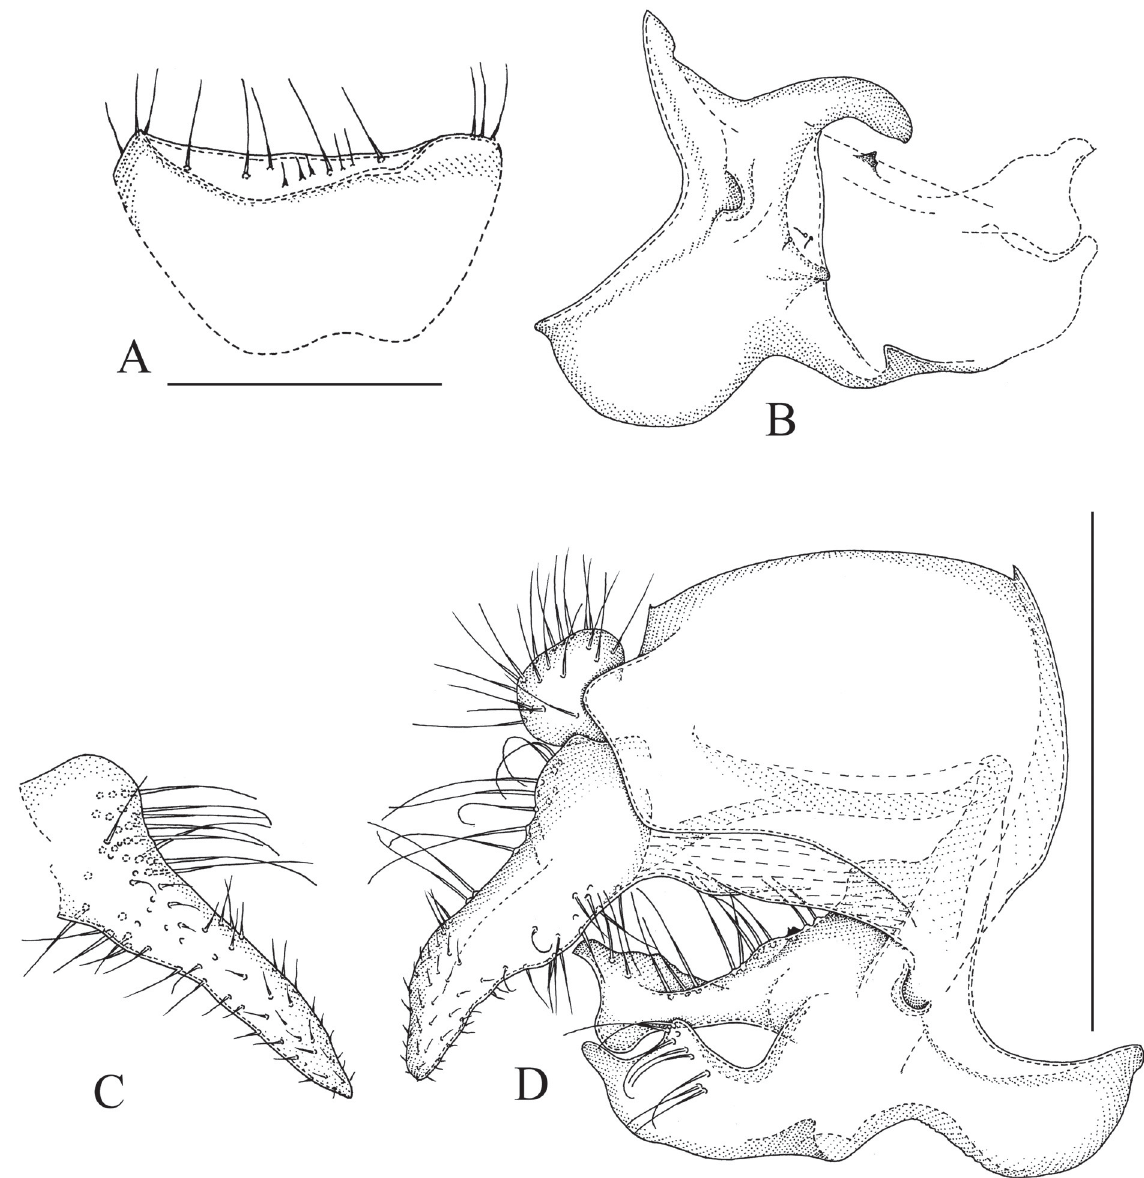
Fig. 24. Sphegina (Asiosphegina) crinita sp. nov., holotype, ♂ (B–D), paratype, ♂ , Malaysia (A). A . Sternum IV, ventral view. B . Left sternum IX and superior lobe, lateral view. C . Left surstylus, lateral view. D . Genitalia, right side, lateral view. Scale bars = 0.5